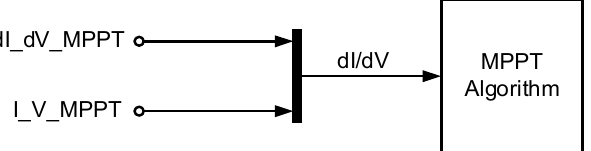
Figure 14. The system for the visualization of the operation of the maximum power point tracking (MPPT) algorithm implemented in Matlab/ Simulink.